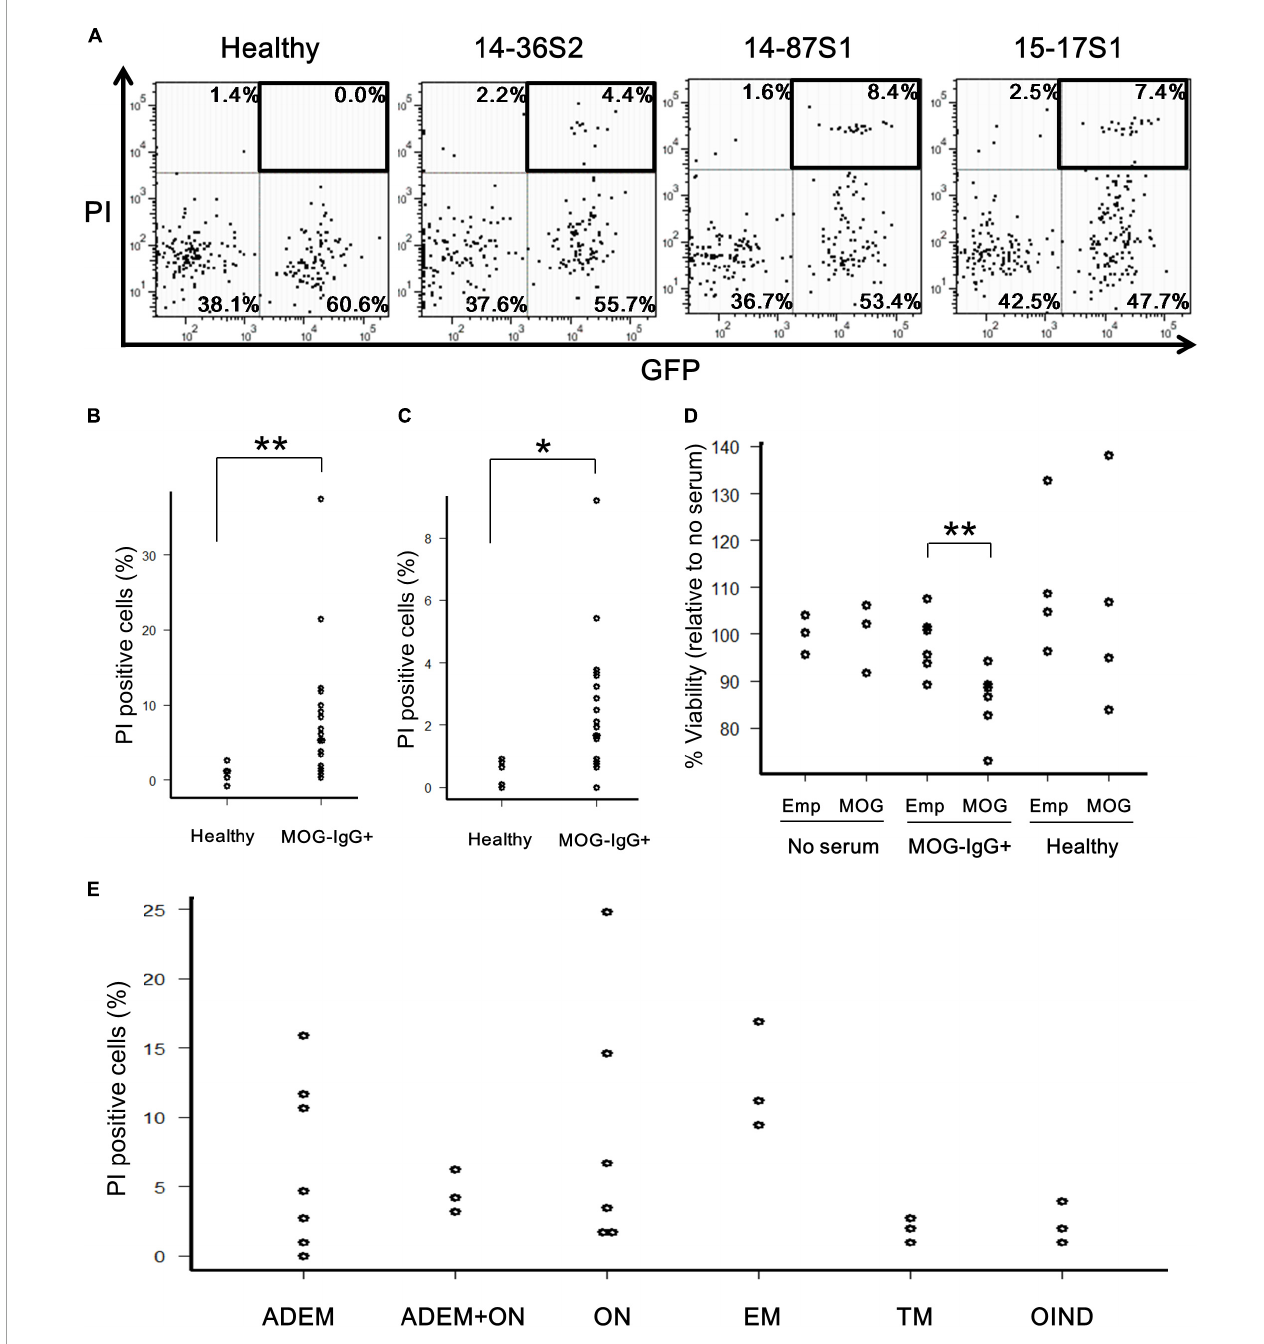
FIGURE2 Cytotoxic effects of anti-MOG antibody in MOG-expressing cells. (A) Representative FACS plots of the cytotoxicity assay. The upper-right GFP + PI + populations (boxed) in the dot plots show damaged MOG-GFP cells. Each proportion of PI-positive cells is calculated as: [number of GFP + PI + (or GFP - PI + ) cells]/[total number of MOG-GFP (or empty) cells]. Cell number in viable gate was considerably reduced because lots of cells died by complement assay. (B,C) Proportion of PI-positive cells among total GFP + cells in the healthy ( n = 6) or anti-MOG-positive ( n = 18) groups. Panel (B) shows a result with rabbit complement and panel (C) shows one with human complement. Statistical significance was determined by Mann–Whitney U test (* P < 0.05, ** P < 0.01). (D) Cell viability of empty (Emp) and MOG-GFP cells (MOG) treated with/without sera measured by the MTS assay. The sample size was no serum ( n = 3), anti-MOG positive serum ( n = 6), and healthy serum ( n = 4). Mann–Whitney U test was used for statistical comparison between Emp and MOG (** P < 0.01). (E) Main data tested for PI-positive cells are plotted by disease group ( n ≥ 3 in each group): 27 patients with confirmed MOG antibody positivity, including ADEM ( n = 7), ADEM + ON ( n = 3), ON ( n = 6), EM ( n = 3), TM ( n = 3), and OIND ( n = 3). Statistical analysis was performed using Kruskal–Wallis test and Steel–Dwass test, and no differences were detected.